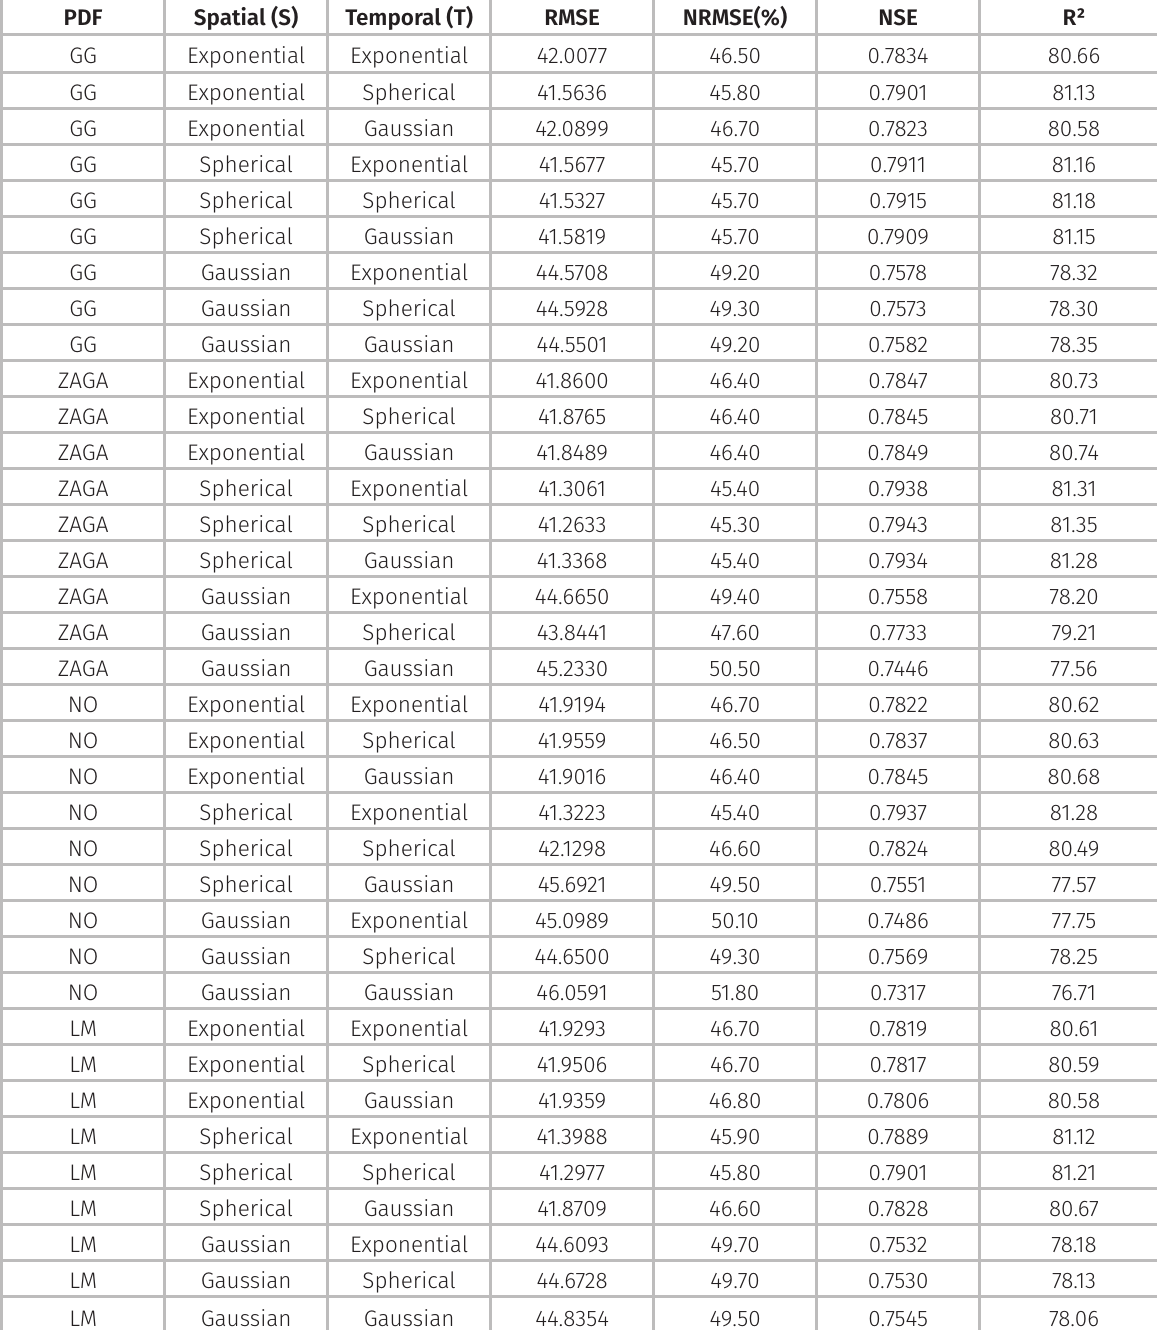
Table I. Results of cross-validation considering the theoretical models of Spherical, Gaussian and Exponential variogram for the Spatial and Temporal components, and the different probability density (PDF) functions for the trend component, being them Generalized Gamma (GG), Zero Adjusted Gamma (ZAGA), Normal GAMLSS (NO) and Linear Model Normal (LM). Metrics to evaluate the error were Root Mean Square Error (RMSE), Normalized Root